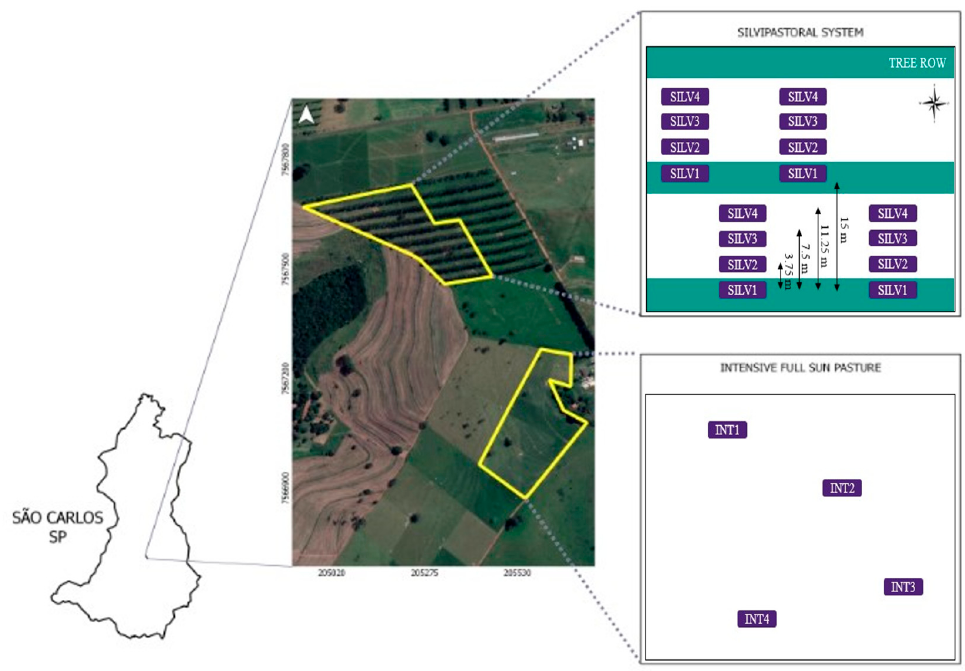
Figure 2. Experimental area (in yellow) with the sampling strategy for the silvopastoral systems (SILV), with different shading levels, and full sun (INT)-Fazenda Canchim, the research center of Embrapa Pecuária Sudeste, São Carlos, SP, Brazil.